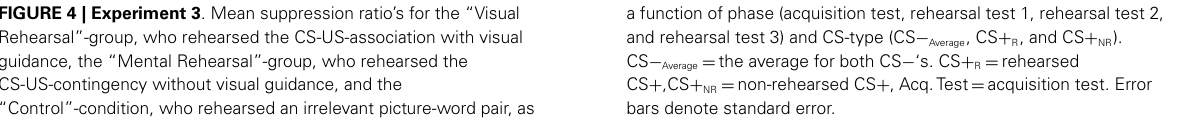
a function of phase (acquisition test, rehearsal test 1, rehearsal test 2, and rehearsal test 3) and CS-type (CS − Average , CS + R , and CS + NR ). CS − Average = the average for both CS − ‘s. CS + R = rehearsed CS + ,CS + NR = non-rehearsed CS + , Acq.Test = acquisition test. Error bars denote standard